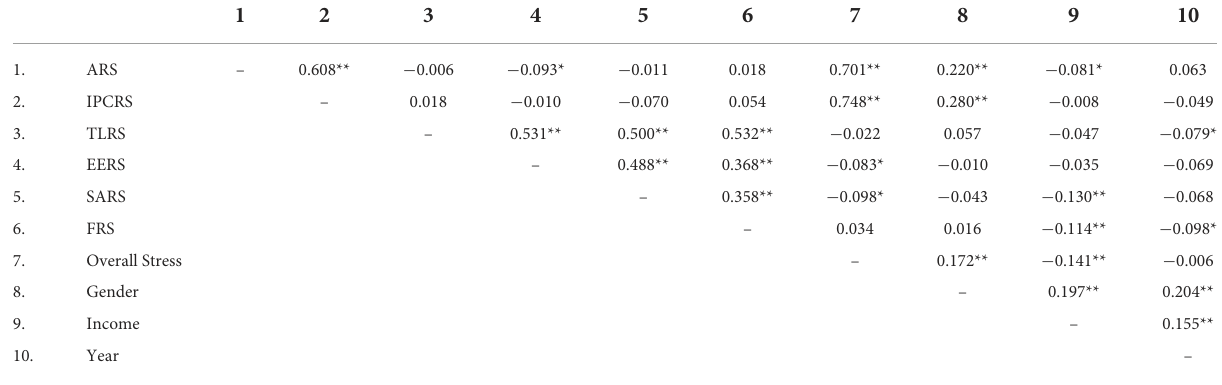
TABLE 4 Correlation analysis of main variables ( N = 611).